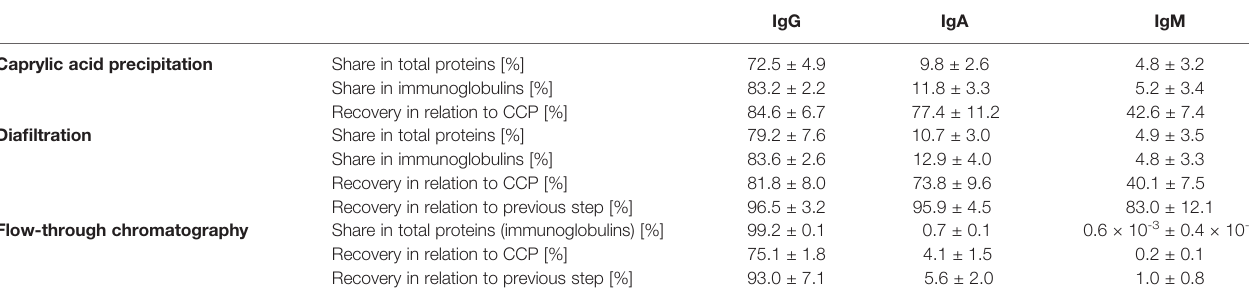
TABLE 1 | Share of IgG, IgA and IgM isotypes within total protein or immunoglobulin content in the intermediate fractions and the fi nal product of developed downstream processing protocol, together with their recoveries in every fractionation